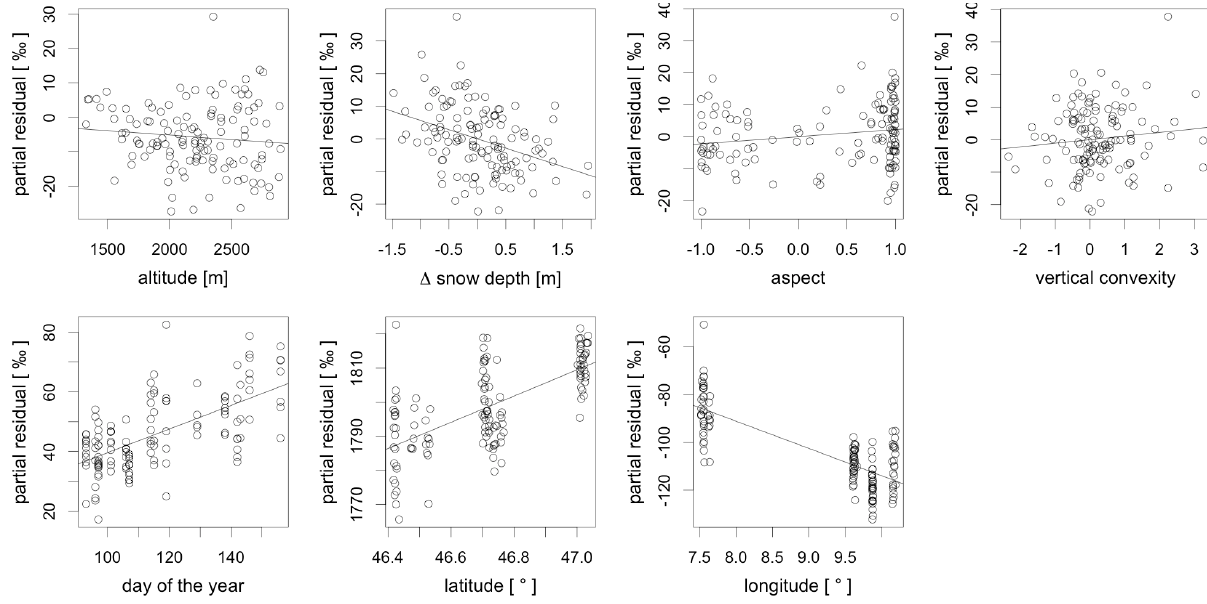
Fig. 6. Partial residuals of each predictor in the regression equitation for all